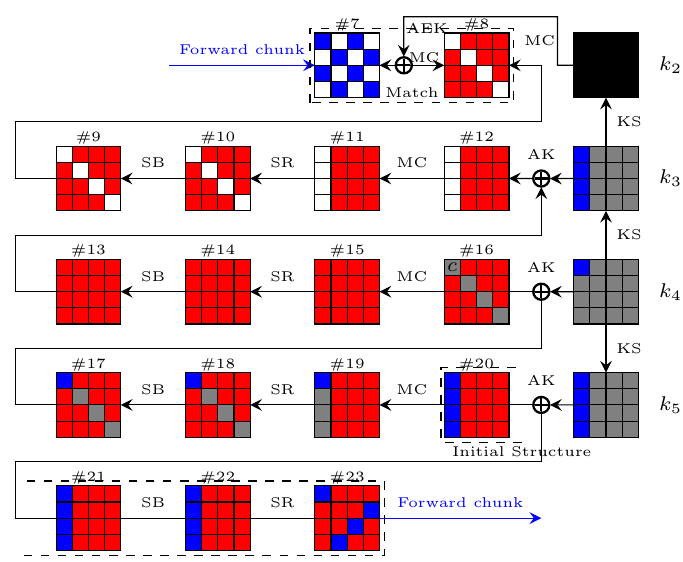
Figure 10: Basic idea of the extended 8-round attack, k 3 and k 5 can have at most one column of neutral bytes each.